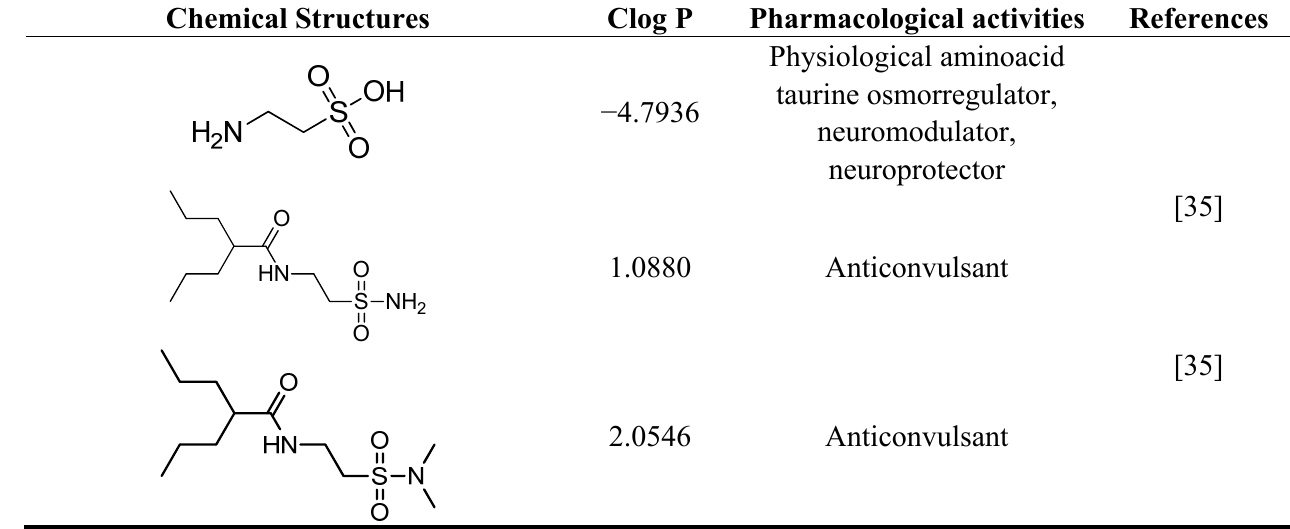
Table 2. CLogP * values of the derivatives of taurine with CNS